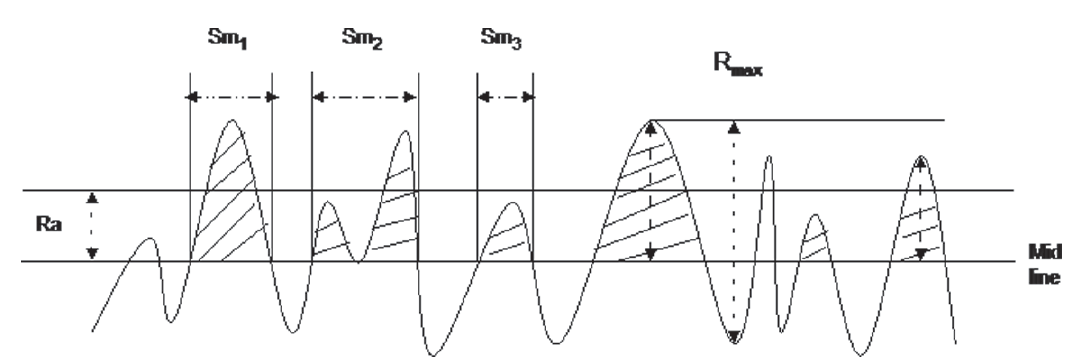
Figure 1- Surface roughness parameters selected, R